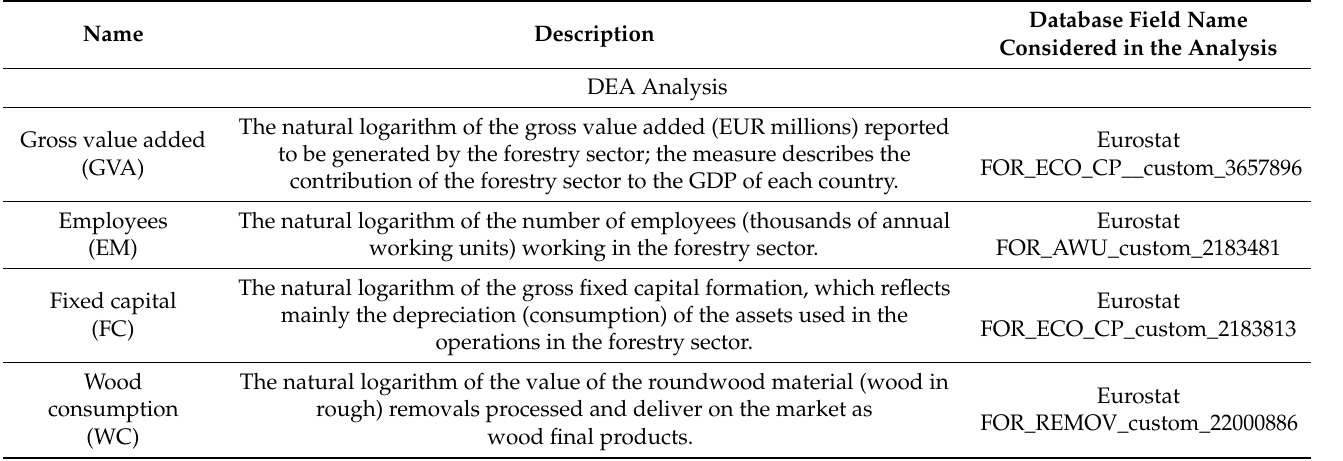
Table 1. Description of variables included in this